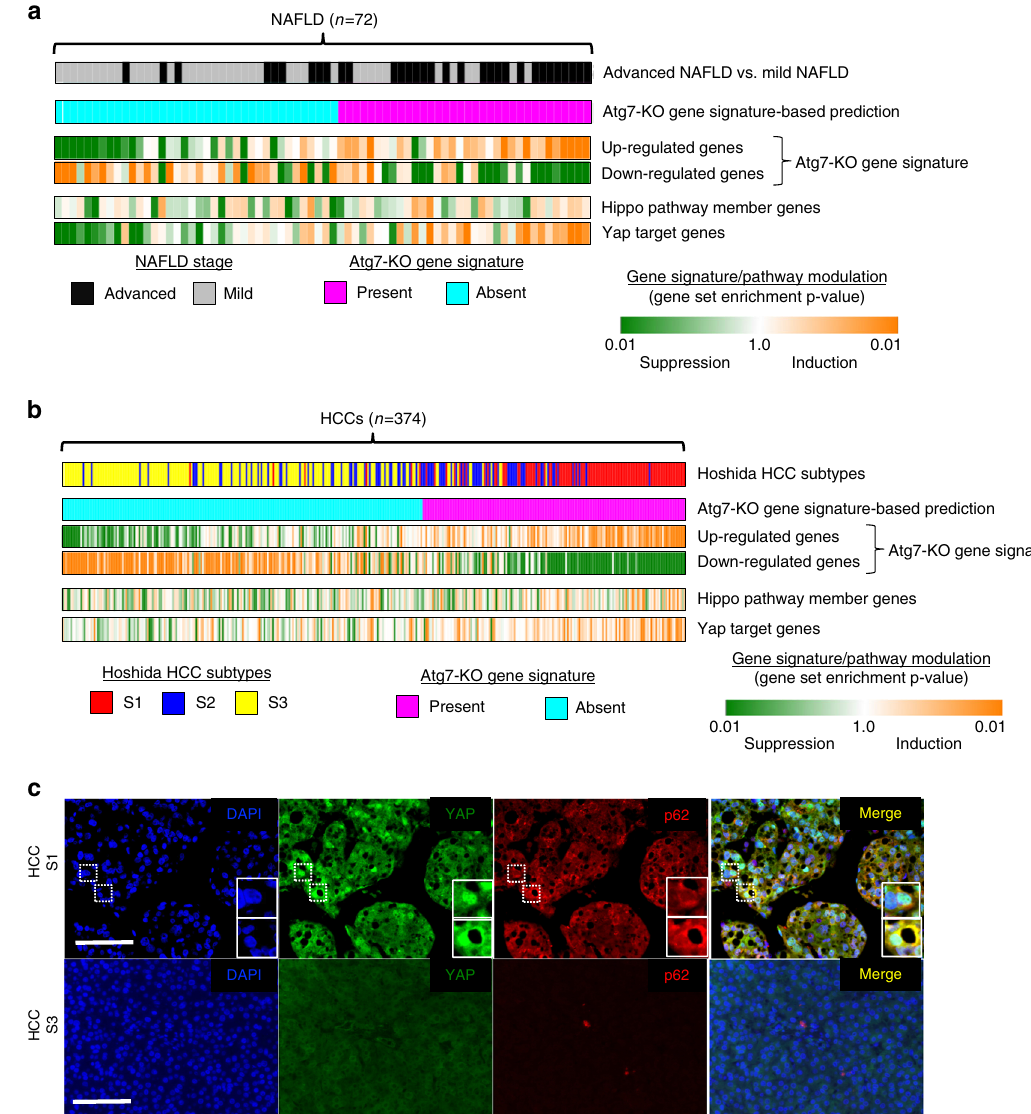
Fig. 6 Atg7-KO gene signature is enriched in transcriptome pro fi les of human NAFLD liver tissues and HCCs. a Gene set enrichment analysis of transcriptome pro fi les of NAFLD liver tissues ( n = 74, advanced (F3, F4) and mild (F0, F1)) with Atg7-KO gene signature and Yap activation signatures. b Gene set enrichment analysis of transcriptome pro fi les of human HCC tissues with Atg7-KO gene signature and Yap activation signatures. c Immuno fl uorescence analysis of human HCC tissue for YAP and P62/SQSTM1. Large insets present magni fi cation of small insets. Scale bar indicates 100 µ